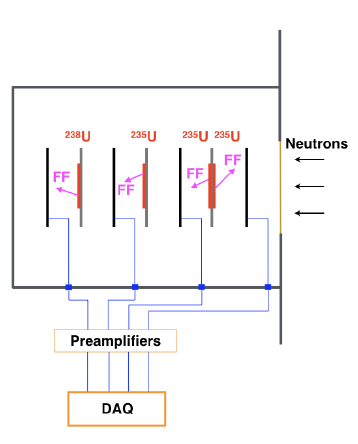
Figure 2: MFC setup at Back-n #ES1.